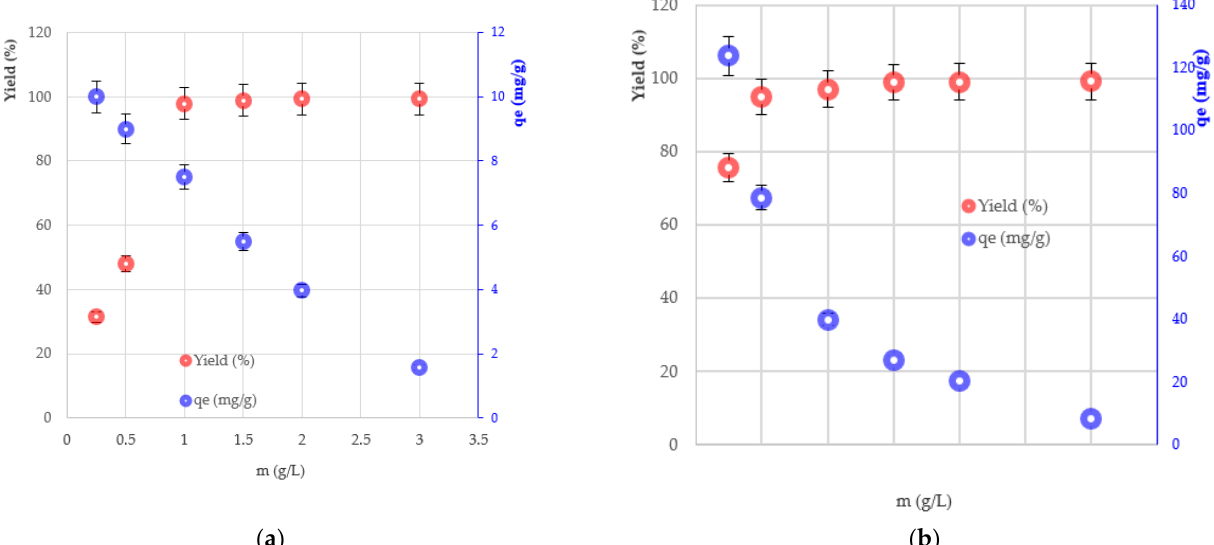
Figure 4. Effect of adsorbent dosage on the percentage of removal and amount of dyes adsorbed on 4AZW: ( a ) MB; ( b ) MG (C 0 (MB) = 8 mg/L, C 0 (MG) = 41 mg/L, contact time 70 4AZW: ( a ) MB; ( b ) MG (C0(MB) = 8 mg/L, C0(MG) = 41 mg/L, contact time 70 min, T = 25 ± 1 ◦ C min, T = 25 ± 1 °C and unadjusted pH). and unadjusted